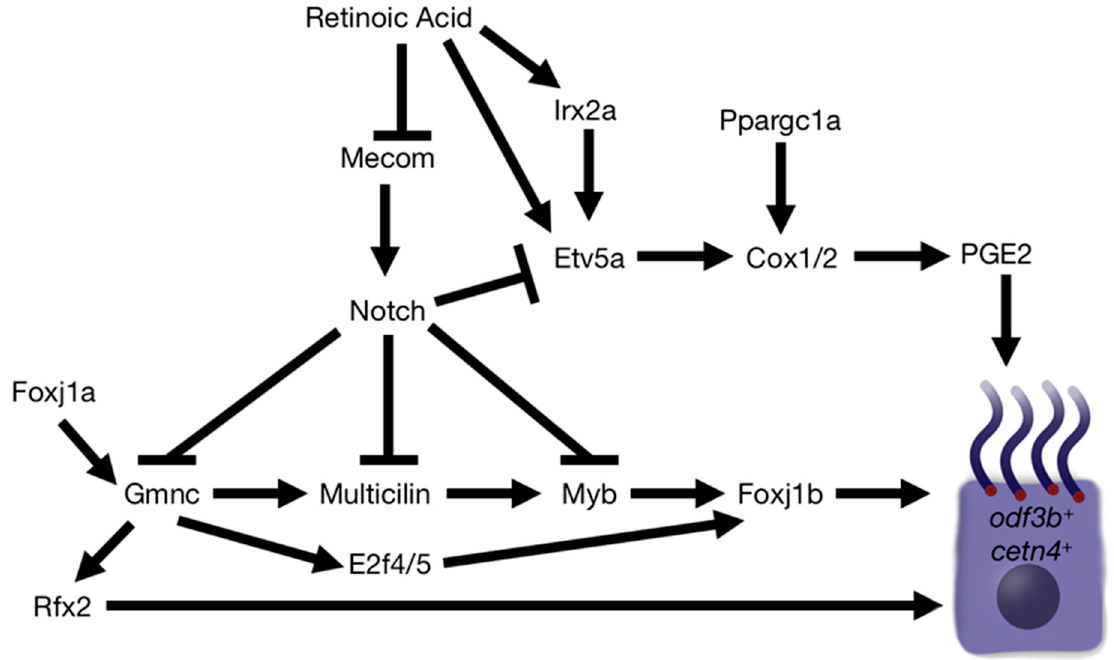
Figure 5. Working model of renal multiciliogenesis in the zebrafish embryo. Genes and signaling pathways demonstrated to be essential for MCC development are depicted.